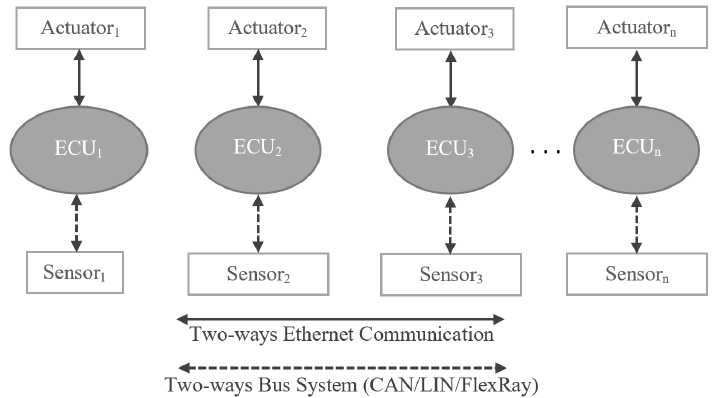
Figure 4. Representation of Traditional E/E